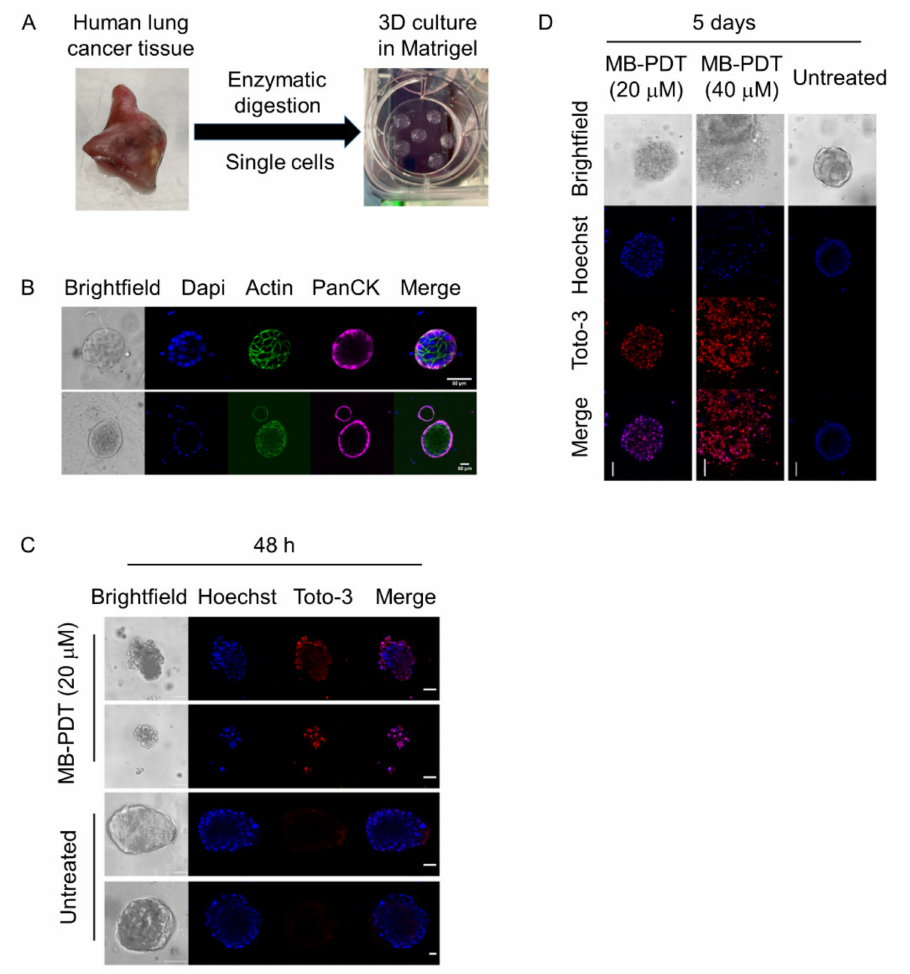
Figure 2. The effects of MB-PDT on apoptosis and morphology in human lung cancer organoids. ( A ) Schematic experimental protocol of human lung cancer 3D culture. ( B ) Representative images of immunofluorescence showing the expression of PanCK, in NSCLC tumour organoids. Images were acquired on a SP8 confocal microscope. Scale bar: 50 µ m. ( C ) Representative live images showing different morphology (Brightfield) and dead cells (Toto-3 iodide, red) of 20 µ M MB-PDT-treated lung cancer organoids 48 h post-treatment. Scale bar: 45 µ m. ( D ) Representative live images of fluorescence of Toto-3 iodide (1 µ M) in MB-PDT-treated lung cancer organoids in a dose-dependent manner five days post-treatment. Images were acquired on a SP8 confocal microscope. Scale bar: 45 µ